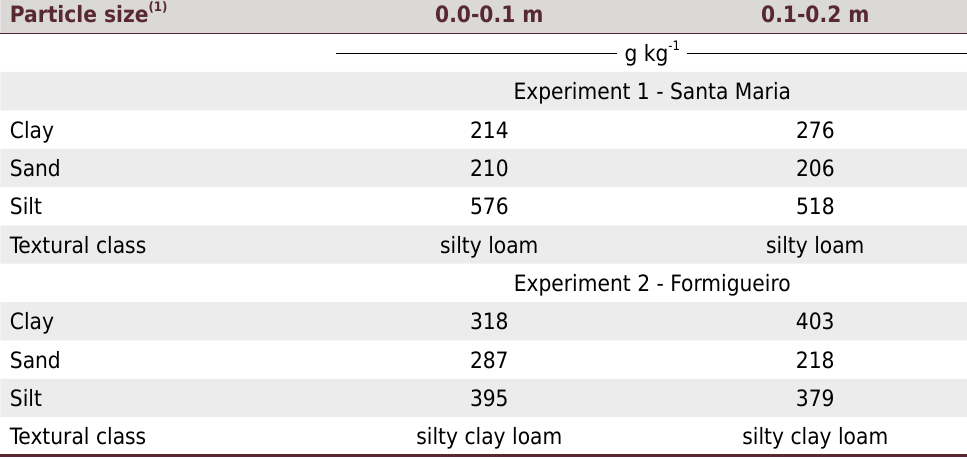
Table 1. Particle size distribution and soil textural class in two soil layers. Santa Maria and Formigueiro, RS, Brazil,